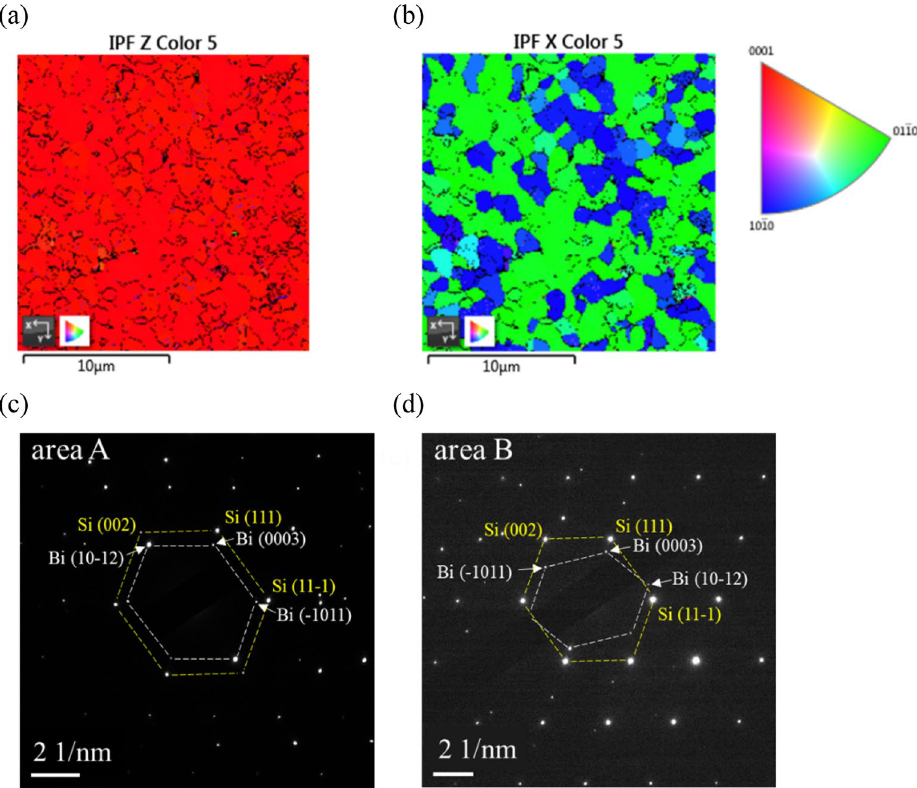
Figure 2. ( a ) IPF Z mapping and ( b ) IPF X mapping of Bi film obtained from EBSD measurement. The crystal orientation along the specified direction is indicated by the colored sector. ( c ) TED images performed at area A and ( d ) area B. The yellow hexagons are connected by Si diffraction spots while the white hexagons are connected by Bi